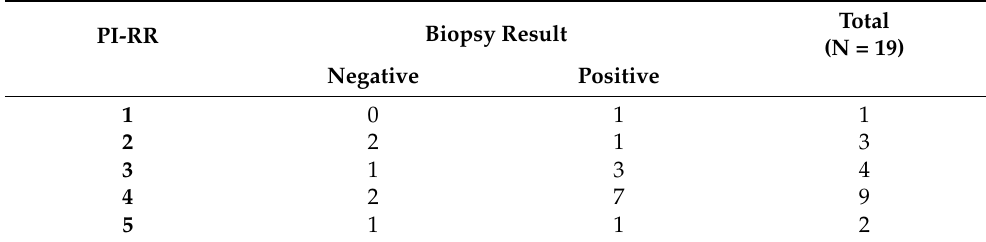
Table 2. PI-RR score distribution in relation to the biopsy